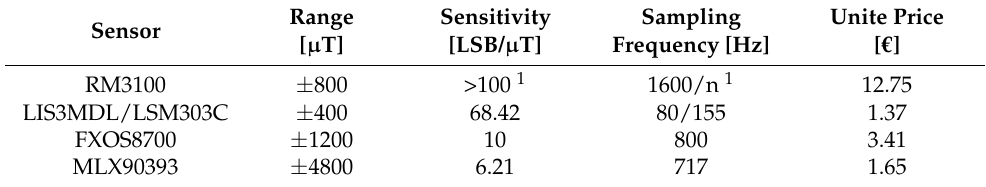
Table 1. Important parameters of